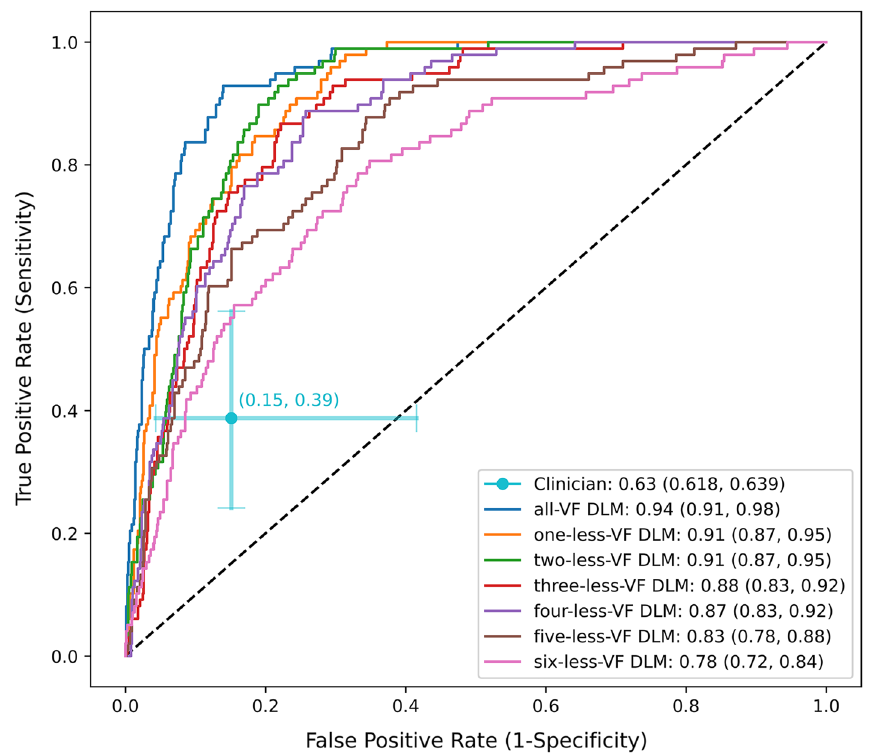
Figure 4. Test set performance of deep learning model and clinician assessment of VF worsening. The blue line shows the model performance with the full data. A decreasing AUC can be seen with the removal of more VFs (rightward shift of ROC curve) to the pink, where 6 of the last VFs were removed. The AUC decreased from 0.94 (0.91, 0.98) to 0.78 (0.72, 0.84) when comparing the full data and removal of 6 VFs, respectively. The cyan dot and 95% CI whiskers show the sensitivity and specificity of clinicians in detecting worsening in the same set of eyes during routine clinical practice. The estimated AUC for clinicians was 0.63 (0.62, 0.64).